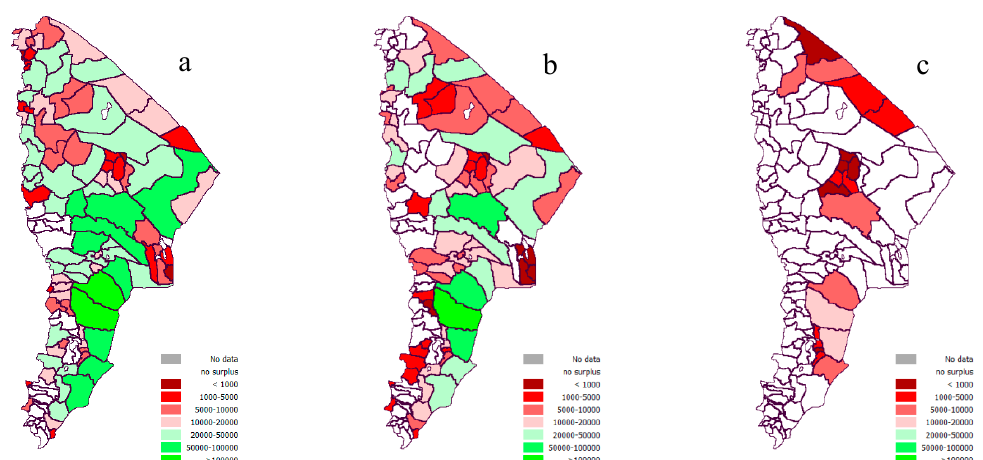
Figure 16. Surplus feed: ‘Best’ (panel a ), ‘Base’ (panel b ) and ‘Worst’ (panel c ) scenario’s (scale 1:7,200,000).